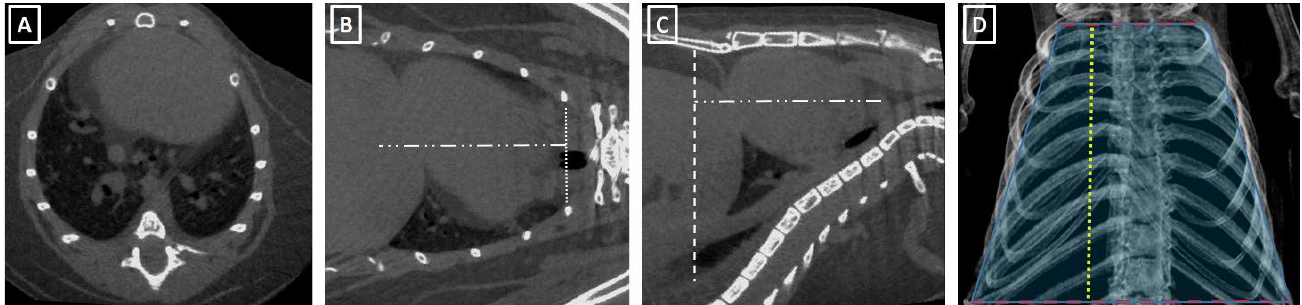
Figure 1. Thoracic volume measuring process. ( A ) Axial reorientation of the thorax. ( B ) Short basis measure line placement at carina level (dot line) and height distance measurement (stripes and dots line) in coronal view. ( C ) Height measure (stripes and dots line) and big basis line placement at diaphragmatic level (stripes line). ( D ) Representative figure of thoracic truncated cone overlaid on thorax µCT.